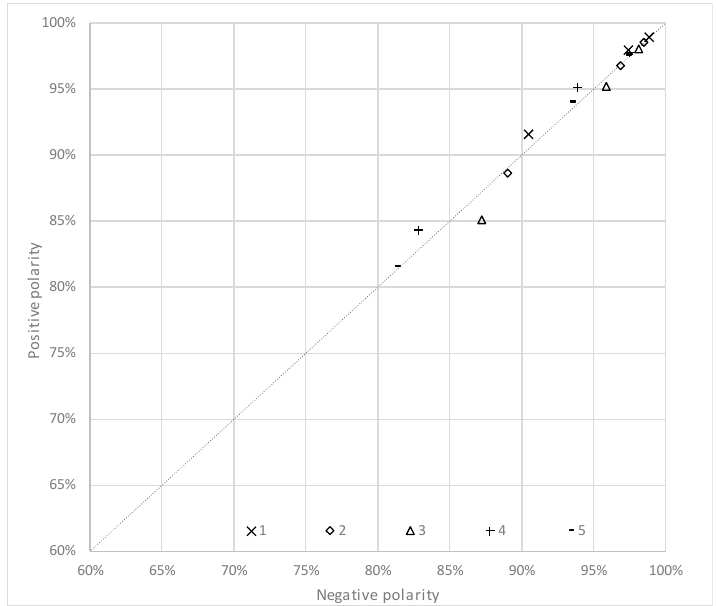
Figure 12. Product PSD after a different number of pulses (feed monosize 2000/1000 µm) and different polarity.